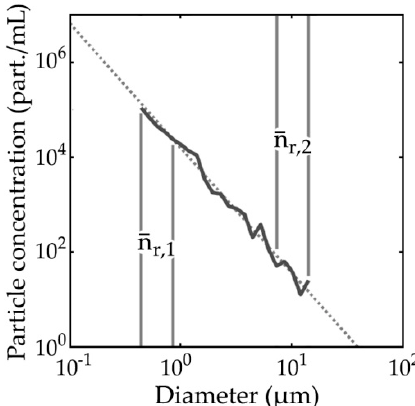
Figure 2. Power law best fit and real refractive index approximation in a typical natural particle population sample. Independent n r values obtained by averaging the n r of particles at the extremes of the PSD ( n r ,1 , n r ,2 ) were used to approximate the real refractive index within the respective ends of the PSD extrapolation (dotted line). The figure was adapted and modified with permission from Figure 3 of Agagliate et al. [2].